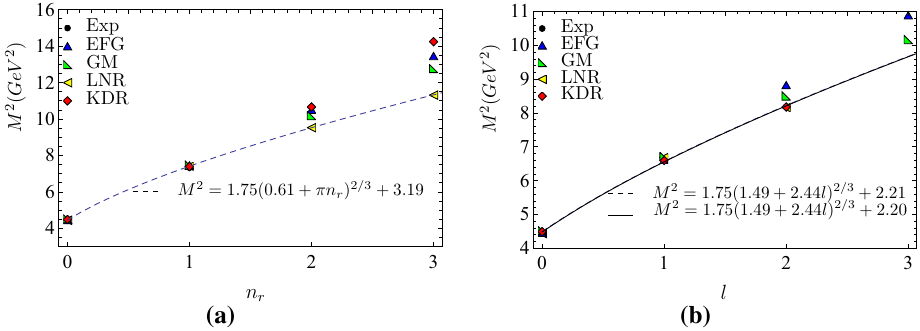
Fig. 4 (Color online) The radial and orbital Regge trajectories for the charmed-strangemesons.ThetheoreticaldataarefromRef.[16](EFG), [53] (GM), [54] (KDR) and [60] (LNR). The experimental data (Exp)